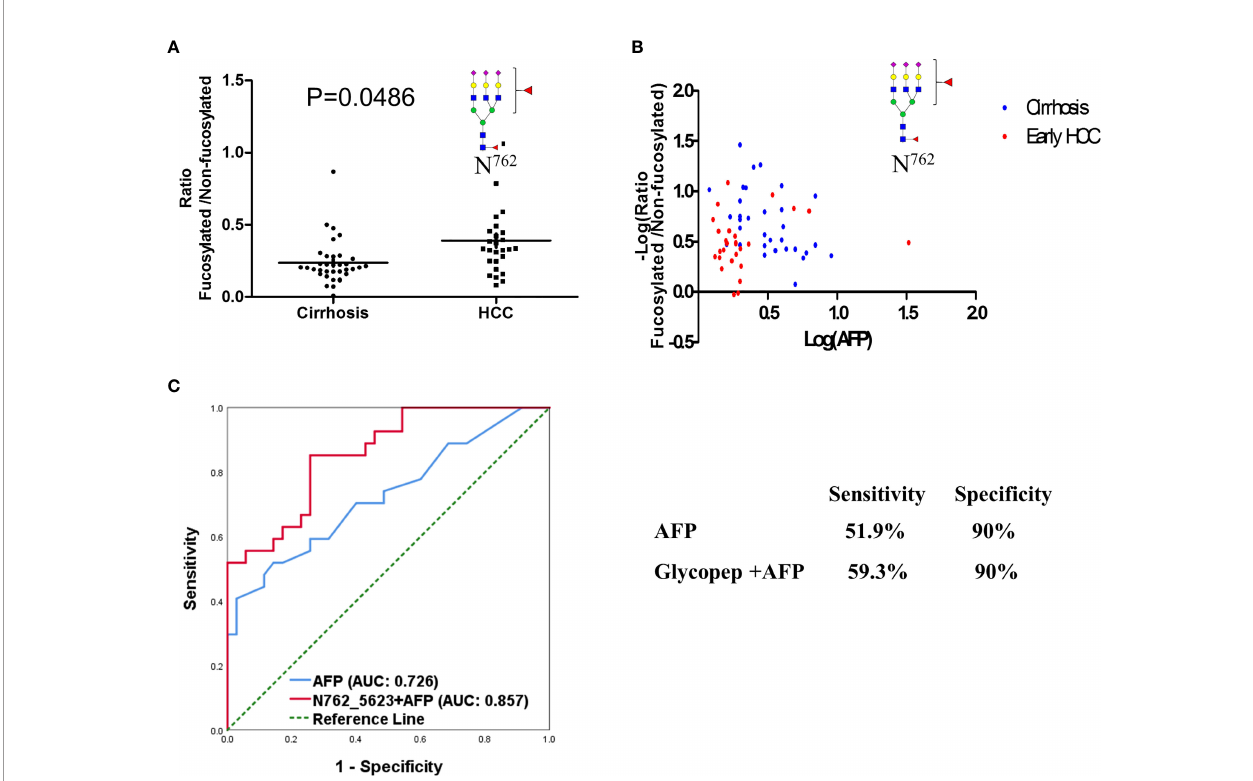
FIGURE 5 | Fucosylation ratio of glycopeptide (A) ELHHLQEQN 762 VSNAFLDK_HexNAc(5)Hex(6)Fuc(2)NeuAc(3)of ceruloplasmin in cirrhosis and early stage HCC serum samples. (B) Two-dimensional plot of AFP and fucosylation ratio of this glycopeptide between cirrhosis and HCC samples. (C) ROC analysis of glycopeptide in combination with AFP in distinguishing HCC from